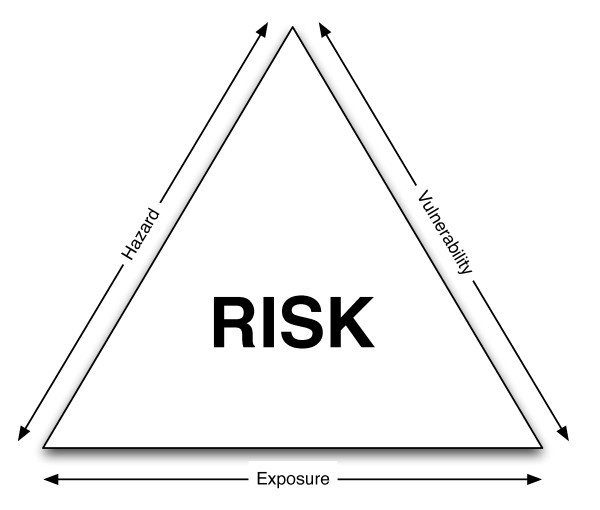
Crichton's risk triangle (from [73] and [75]).